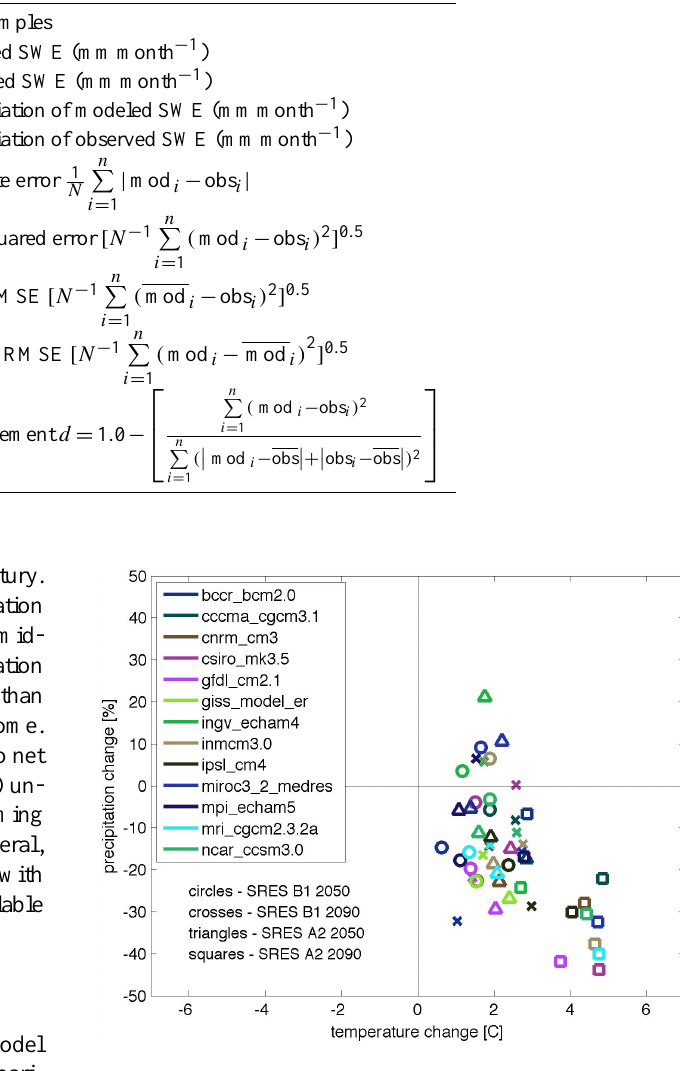
Fig. 3. Cold season (DJFMA) averaged changes in near surface air temperature and precipitation from baseline conditions (1961– 1990) predicted by 13 models for four scenario/time combina- tions. Different colors correspond to different models, while marker shapes indicates the scenario/time pair. Positive values in the tem- perature field indicate increases in temperature, while negative val- ues in the precipitation field indicate relative decreases in precipita- tion amounts as a result of climate